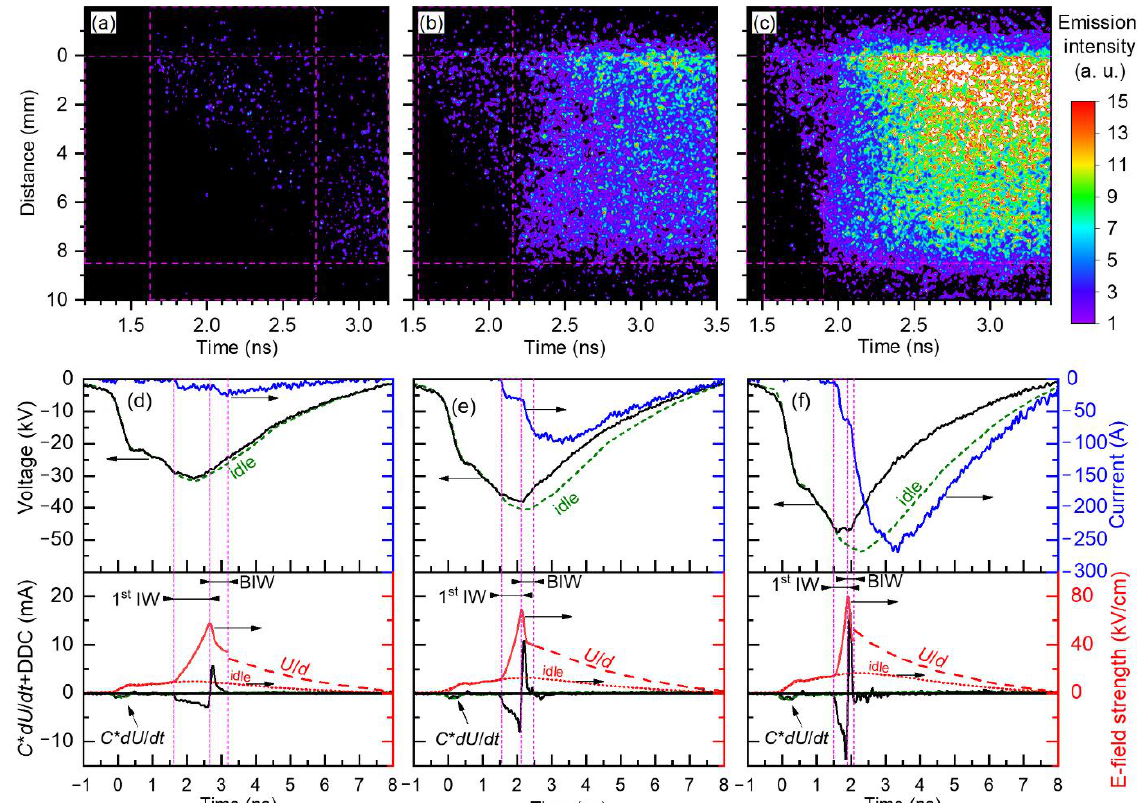
Figure 5. ( a – c ) Streak-images of the discharge formation dynamics and ( d – f ) corresponding waveforms of voltage, U gap , current, I d , displacement current ( C gap dU gap / dt + DDC) measured with the collector placed downstream the grounded grid electrode, and the electric field strength (calculated) near the surface of the grounded electrode at various voltages across the gap. 1st IW — first ionization wave (streamer), BIW — backward ionization wave. Air at a pressure of 100 kPa.